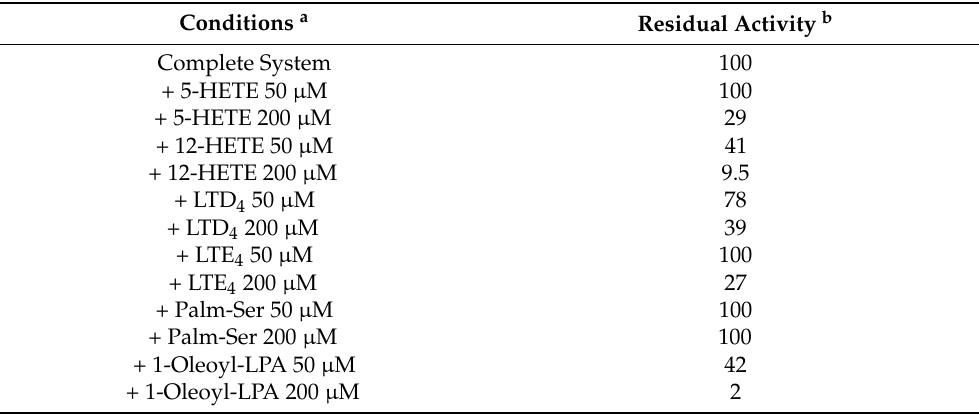
Table 1. Effects of some fatty acids on the ω -hydroxylation of LTB 4 catalyzed by yeast microsomes expressing CYP2U1 and CPR.